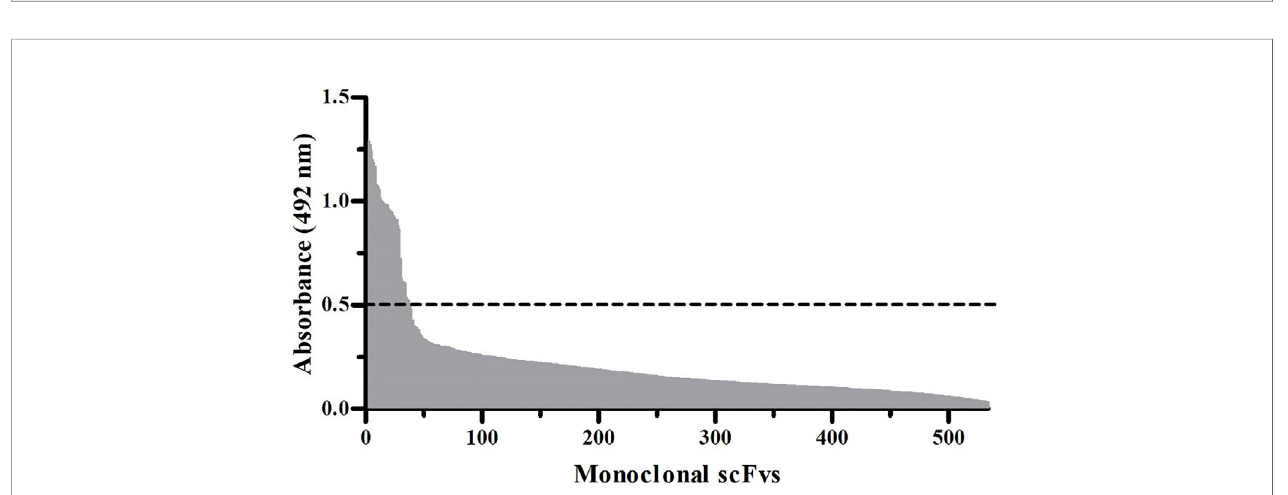
FIGURE 2 | Monoclonal scFv ELISA signals against a -LTX. In total, 534 scFv clones were expressed in solution and screened for their ability to bind directly coated a -LTX. scFvs displaying a binding signal above the cut-off absorbance value of 0.5 (dotted line) at 492 nm were considered ( Figure 5A ), indicating that those EPSCs were mediated by ionotropic glutamate receptors. Our data on a -LTX action are in good agreement with previous results on a -LTX action [e.g., (33)]. Preincubation of a -LTX with IgG TPL0020_02_G9 at 1:10